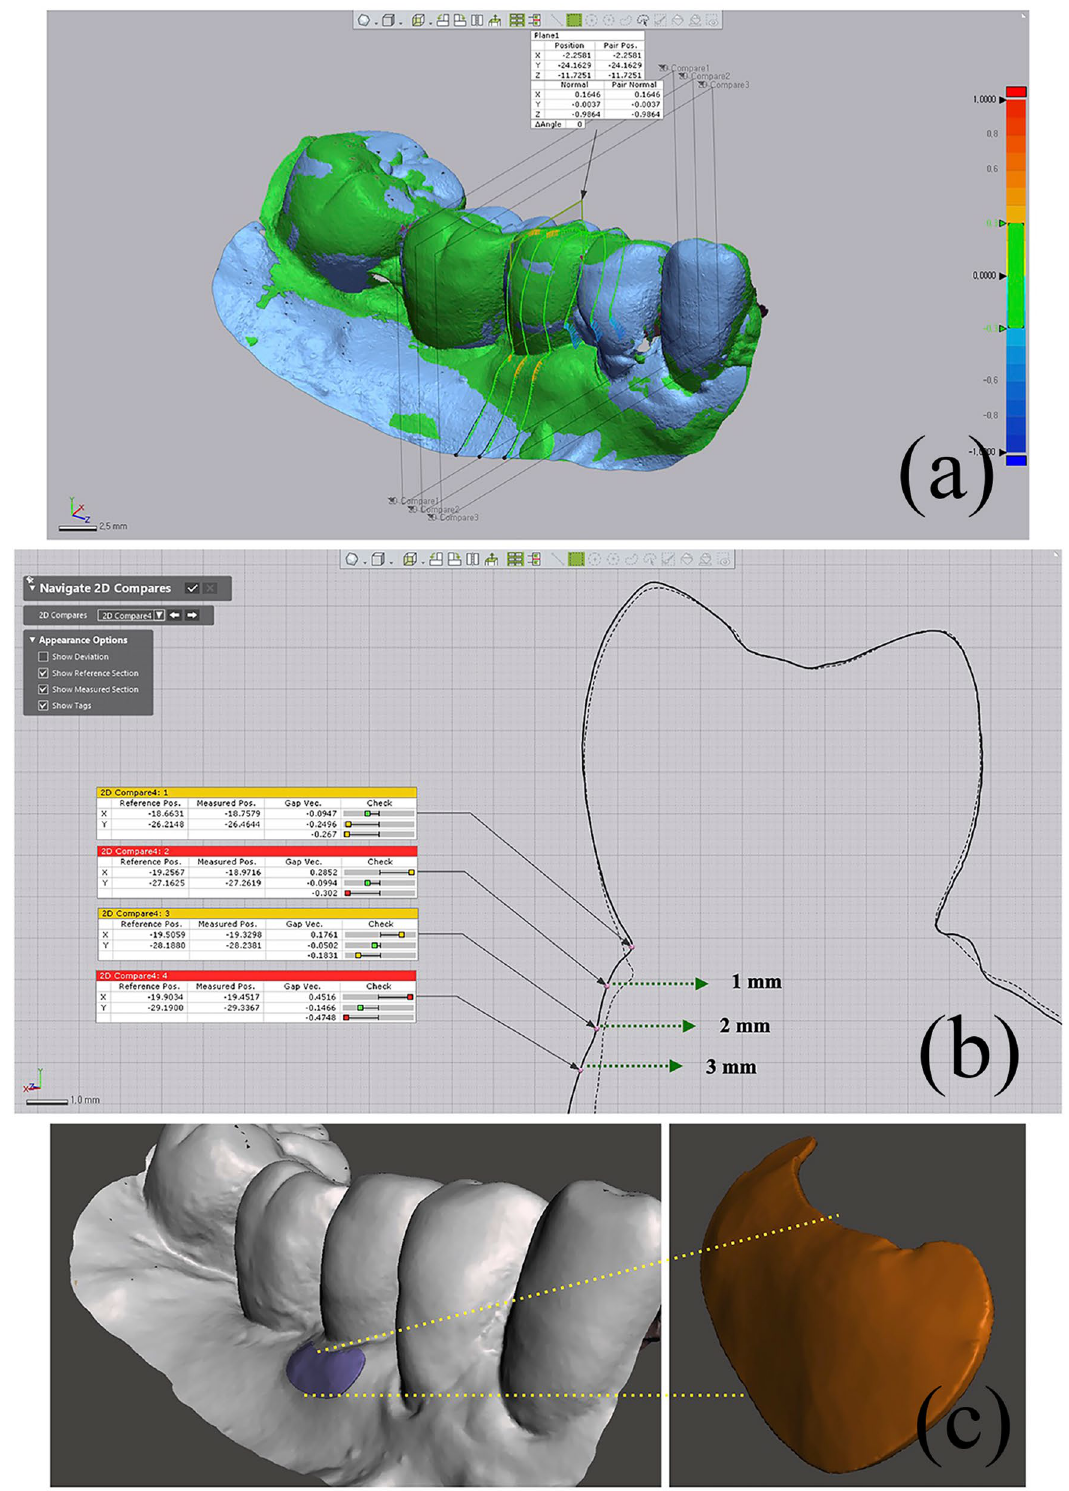
Figure 2. Linear and volumetric measurements. ( a ) The linear difference between the two time points was calculated in the mid-facial lines and mesial/distal line angles. ( b ) The difference was calculated at 1-mm, 2-mm, and 3-mm levels below the mucosal margin. ( c ) The volume difference was calculated in the set area of interest. The following are the reference points: 1 mm and 3 mm below the mucosal margin of the implant crown, extension lines of mesial and distal line angle